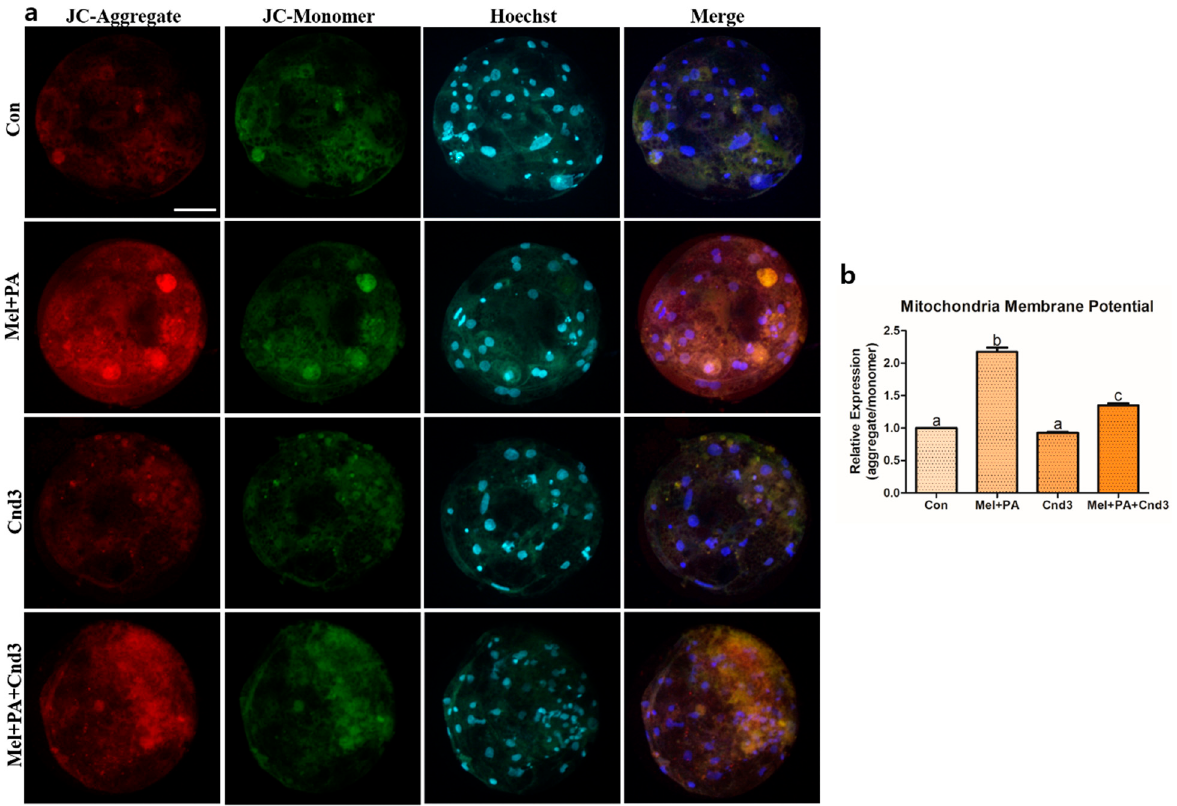
Figure 8. Representative images of JC-1 MMP staining in blastocysts. Fluorescence microscopy was applied to obtain images of the blastocysts. ( a ) Representative blastocysts in each group were stained with JC-1 aggregate and JC-1 monomer, then counter-stained with Hoechst 33342. ( b ) Analysis of intensities from JC-1 MMP-stained blastocysts. At least 15 blastocysts from four biological replications in each group were used for the staining and it was performed three times technically. Data are shown as the means ± SEM. Bars with different alphabetical letters are significantly different ( p < 0.05). Con, control; mel, melatonin, PA, phytanic acid; Cnd3, siRNA candidate 3. White bars in the images indicate 50 μ m; 400× magnification.